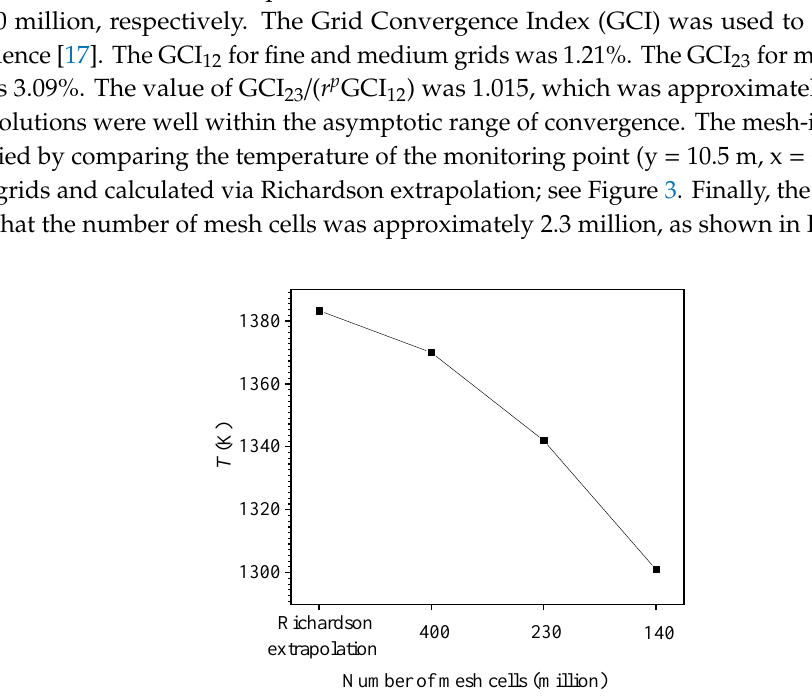
Figure 3. The temperature of a monitoring point simulated on three grids and calculated via Richardson extrapolation.